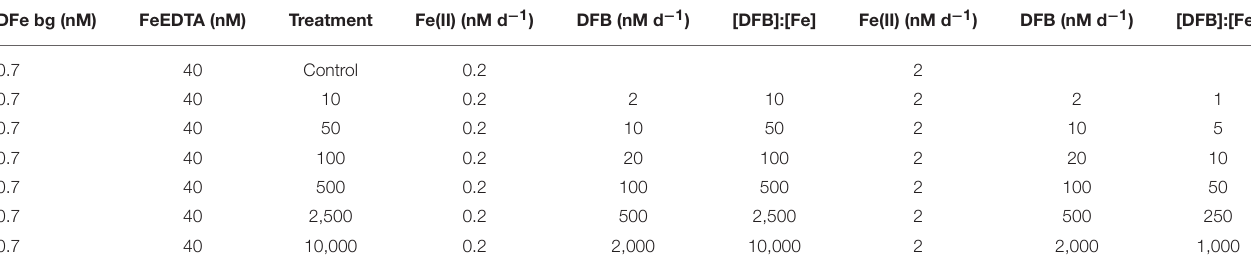
TABLE 2 | Background dissolved labile iron (DFe) (nM) and FeEDTA complex (nM) present in the culture medium (Left). Supply ratio of desferrioxamine B (DFB) to iron(II) ratio added every other day for the 1nM (Center) and 10nM (Right) Fe(II) conditions until target concentrations were reached for each treatment in the experiment performed with S. costatum and A. catenella